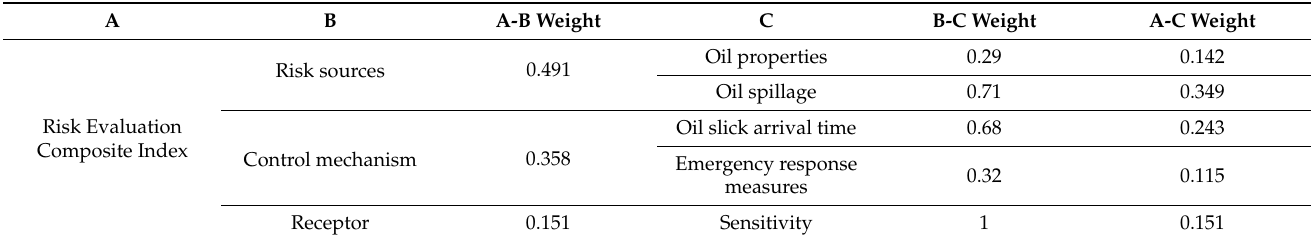
Table 8. Risk evaluation index system and weights of sudden oil spill accidents.